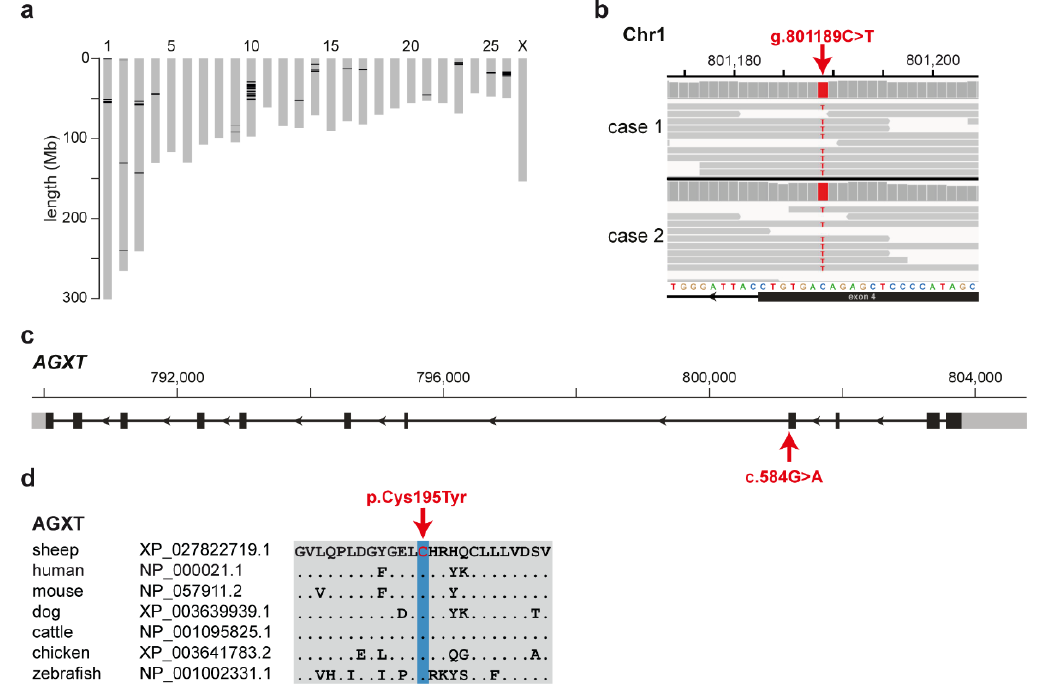
Figure 2. A missense variant in the alanine-glyoxylate aminotransferase ( AGXT ) gene is associated with type I primary hyperoxaluria (PH1) in Zwartbles sheep. ( a ) Representation of ovine chromosomes (grey bars) with highlighted regions of shared homozygosity (in black) in the two PH1-a ff ected sheep with whole-genome sequence (WGS) data. ( b ) IGV [12] screenshot of the PH1-a ff ected sheep WGS shows the missense variant present in both cases. ( c ) Schematic representation of the AGXT gene showing the variant location in exon 4. ( d ) Conservation of the a ff ected amino acid in the AGXT protein across multiple species. Table1.